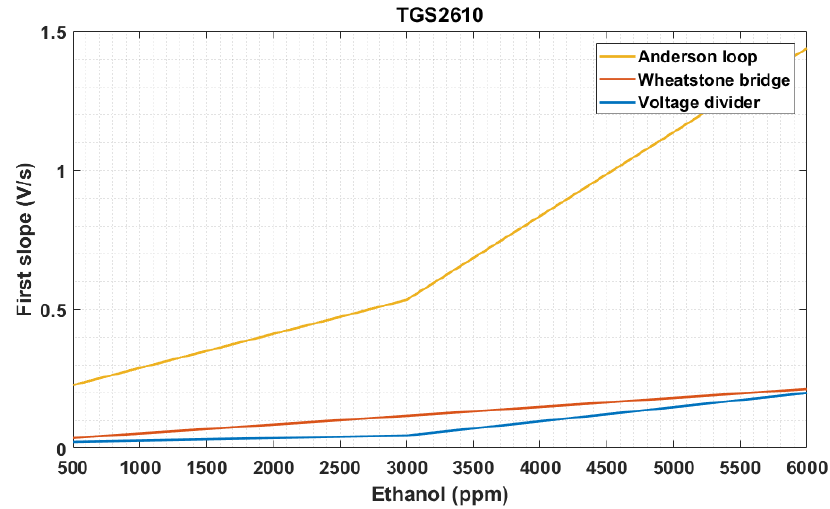
Figure 16. Value of first slope measured with the TGS 2610 in the rising edge.